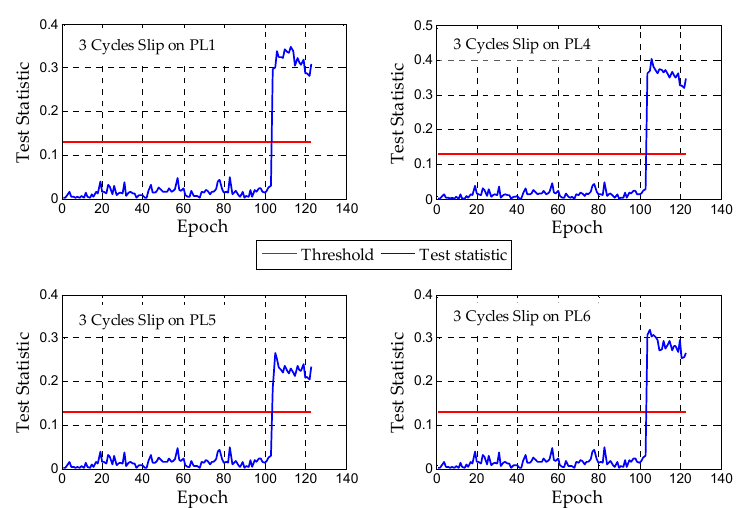
Figure 14. Test Statistics when simulated cycle slips are added.